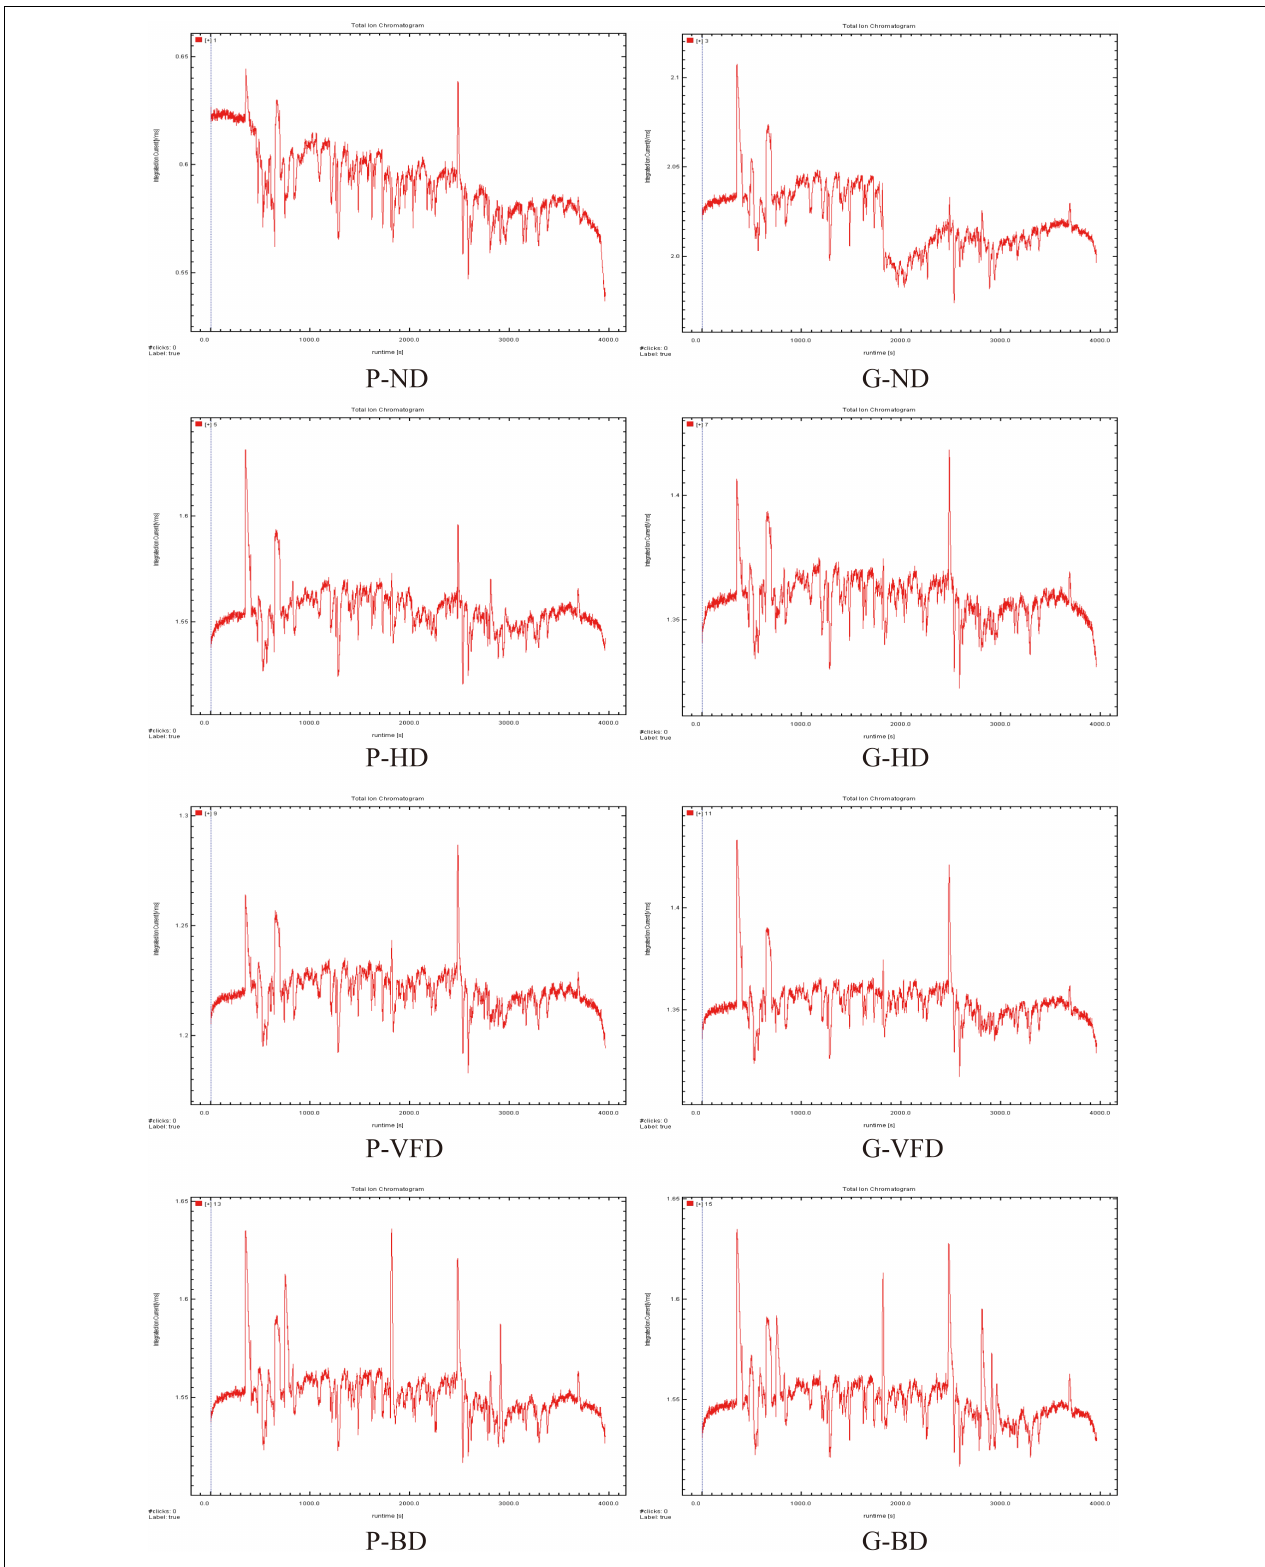
FIGURE 2 | Chromatograms of volatile compounds extracted from dried asparagus roots using gas-chromatography ion mobility spectrometry. For compounds listed in Table 1 .